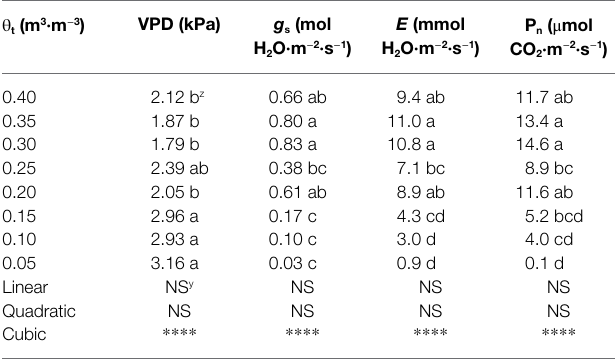
TABLE 4 | Leaf-to-air vapor pressure deficit (VPD), stomatal conductance ( g s ), transpiration rate ( E ), and net assimilation rate (P n ) of Shepherdia ×utahensis at eight substrate volumetric water content treatments ( θ t ).